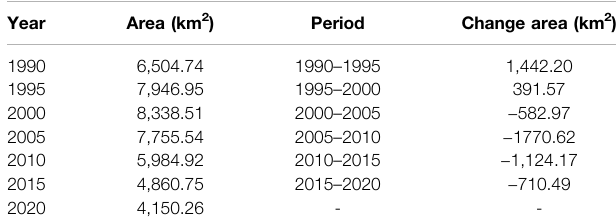
TABLE 3 | Areas and changes in sandy land area between 1990 and